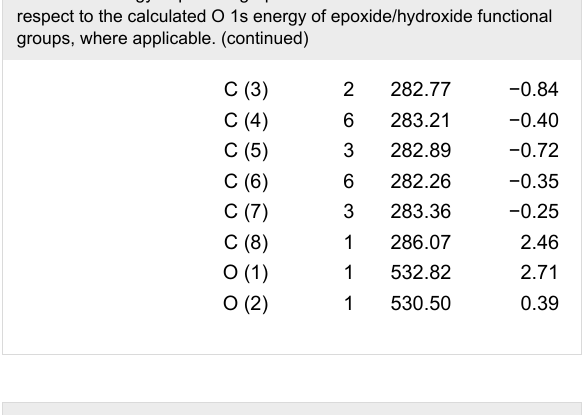
Table 3: Calculation results for the saturated single vacancy struc- tures. The columns show: system identifier; formation energy of the defect; target atom of the calculation (see Figure 3); number of target atoms; calculated 1s binding energy; C 1s BE shift with respect to the calculated C 1s energy of pristine graphene or the O 1s BE shift with respect to the calculated O 1s energy of epoxide/hydroxide functional groups, where